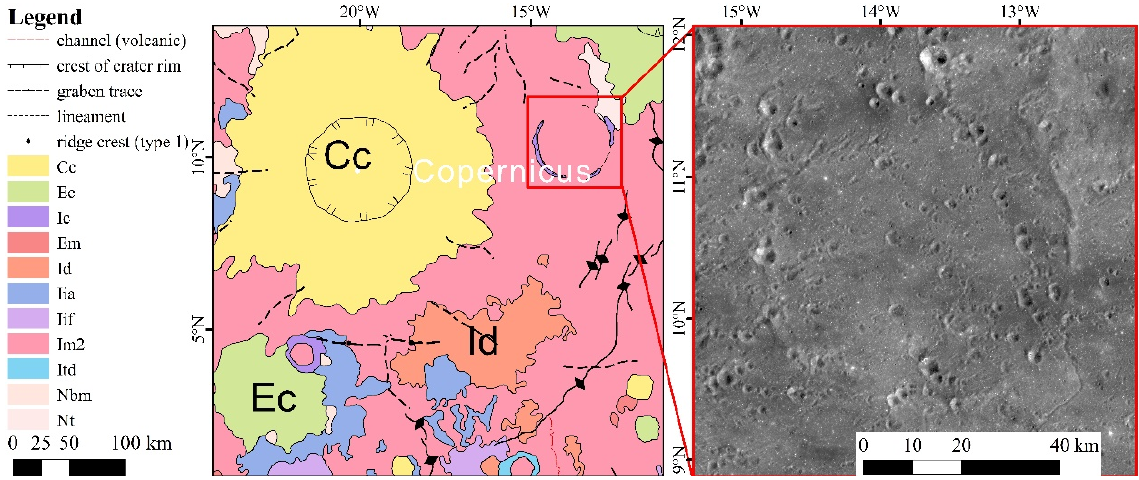
Figure 17. Stadius crater on the geological map and the Kaguya TCortho Mosaic.